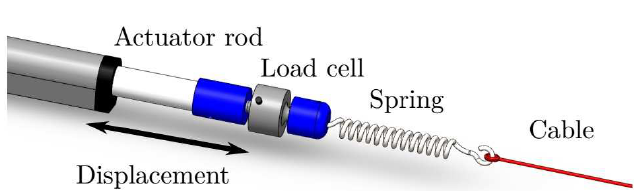
Figure 4. Linear actuator, load cell, spring, and cable